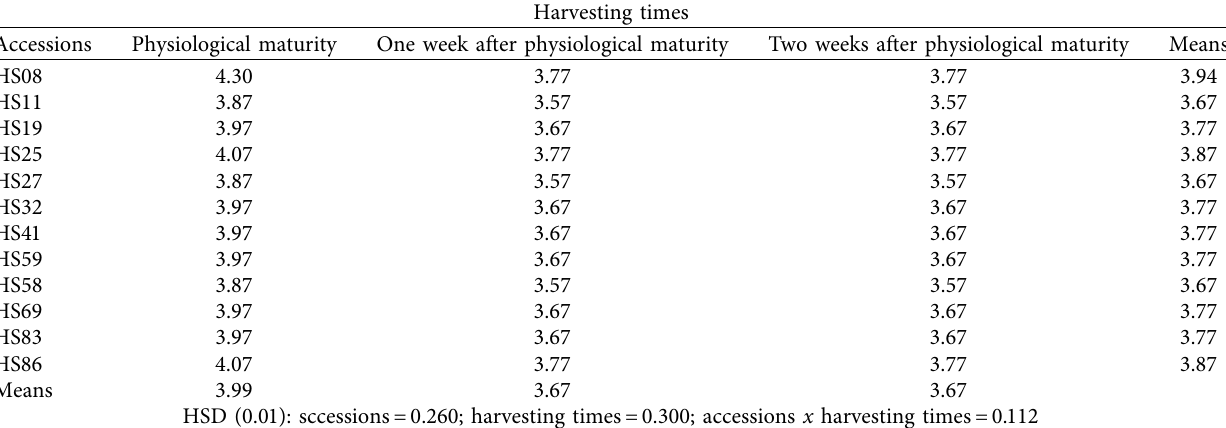
Table 3: Interactive effects of harvesting times x accessions on the seed width (mm) of roselle.